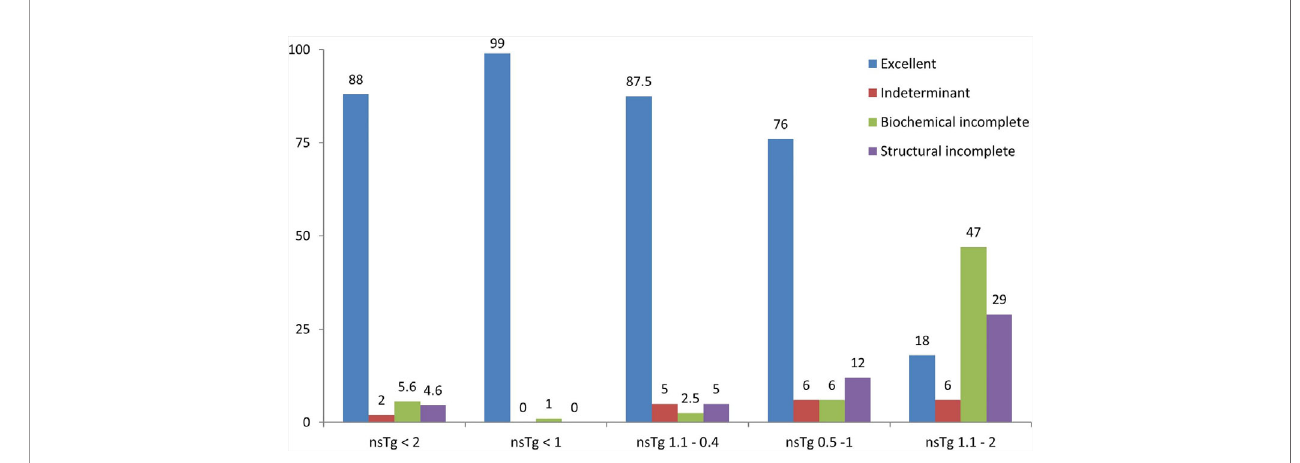
FIGURE 3 | Graphical representation of the clinical response of patients in percentage (%) stated in February 2020, after a median follow-up of 84 months. 196 patients were included from February 2011 to February 2015 following total thyroidectomy and radioactive iodine (RAI) ablations, with initial suppressed thyroglobulin below 2 ng/ml done 3 – 6 months following the RAI ablation. Patients were grouped according to the initial non-stimulated thyroglobulin. nsTg, serum non-stimulated